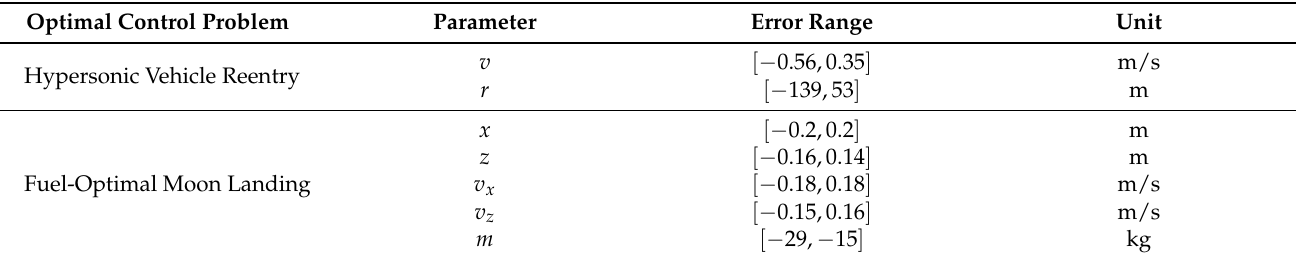
Figure 12. The comparison of the closed-loop guidance trajectory for FOML. Table 7. Terminal errors of two